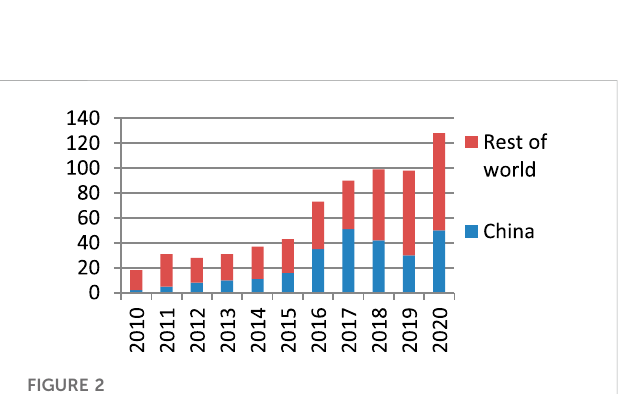
FIGURE 2 Solar capacity (Annual change, GW). Source: BP statistical reviews of world energy